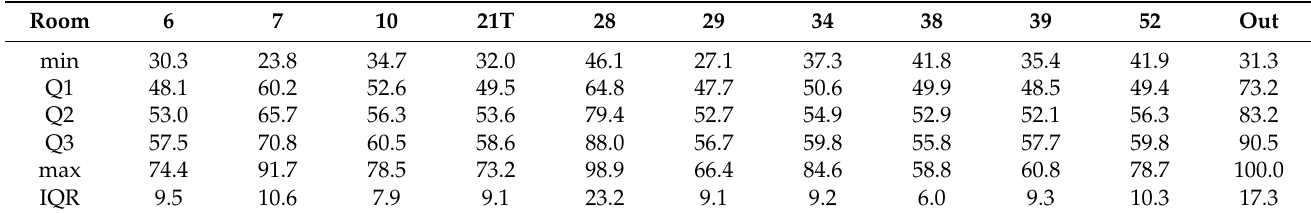
Table 3. Summary of the statistical parameters (same as in Table 2) for relative humidity (%) data over the period 1 June 2017, until 31 May